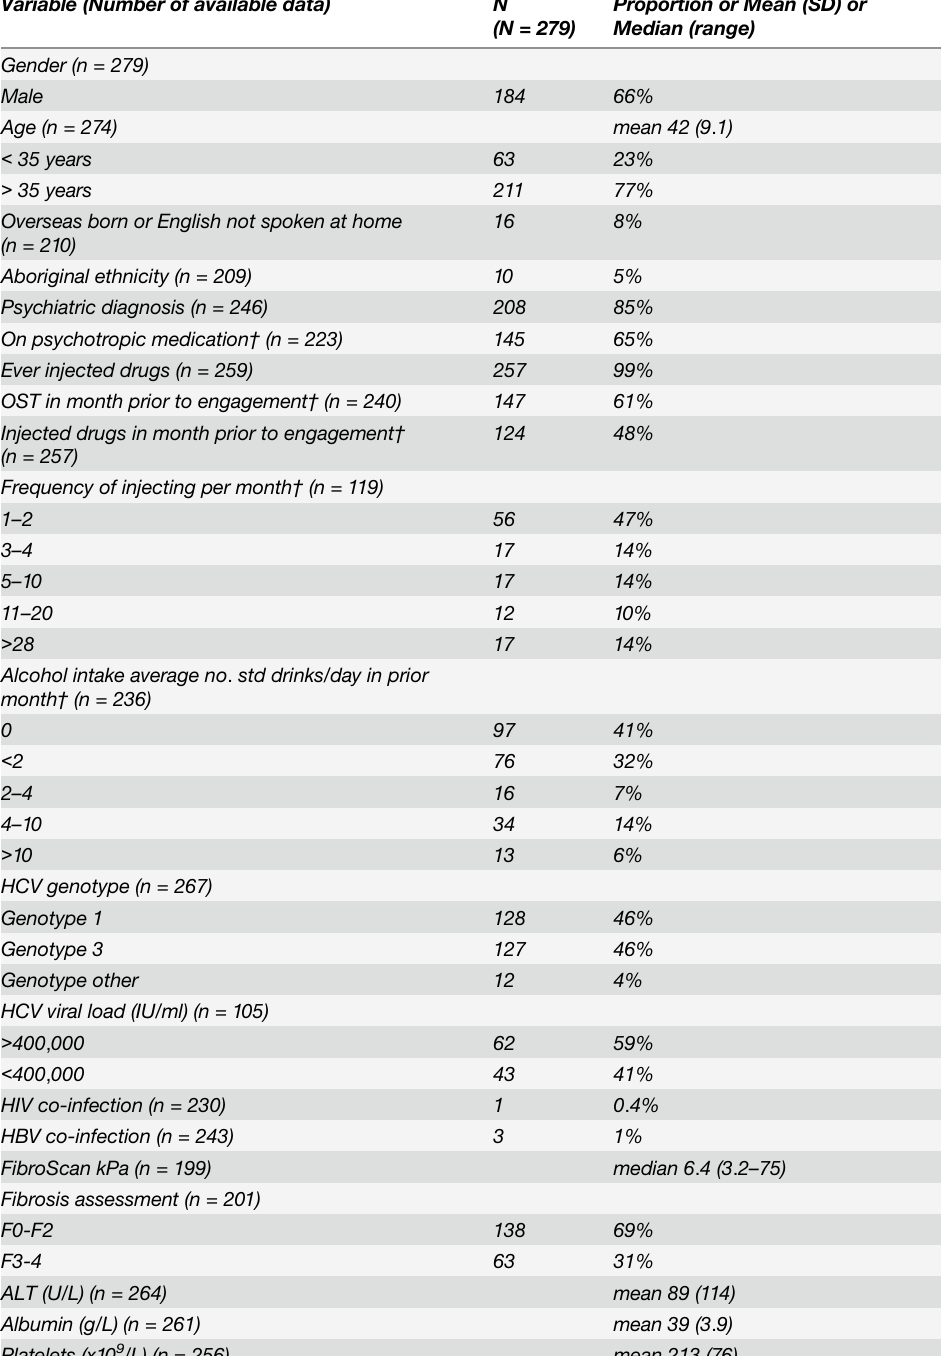
Table 1. Patient demographic and clinical characteristics. Variable (Number of available